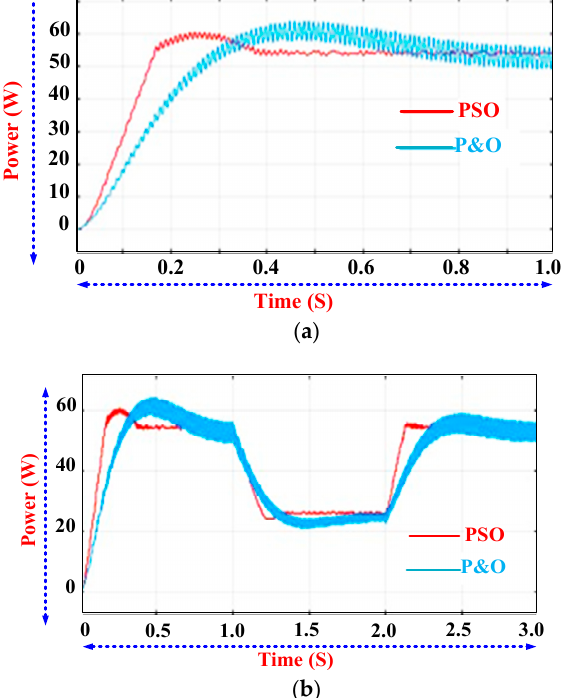
Figure 15. Comparison of output power from PSO based MPPT and P&O based MPPT for ( a ) 1000 W/m 2 ; ( b ) irradiance is varied from 1000 W/m 2 to 500 W/m 2 .